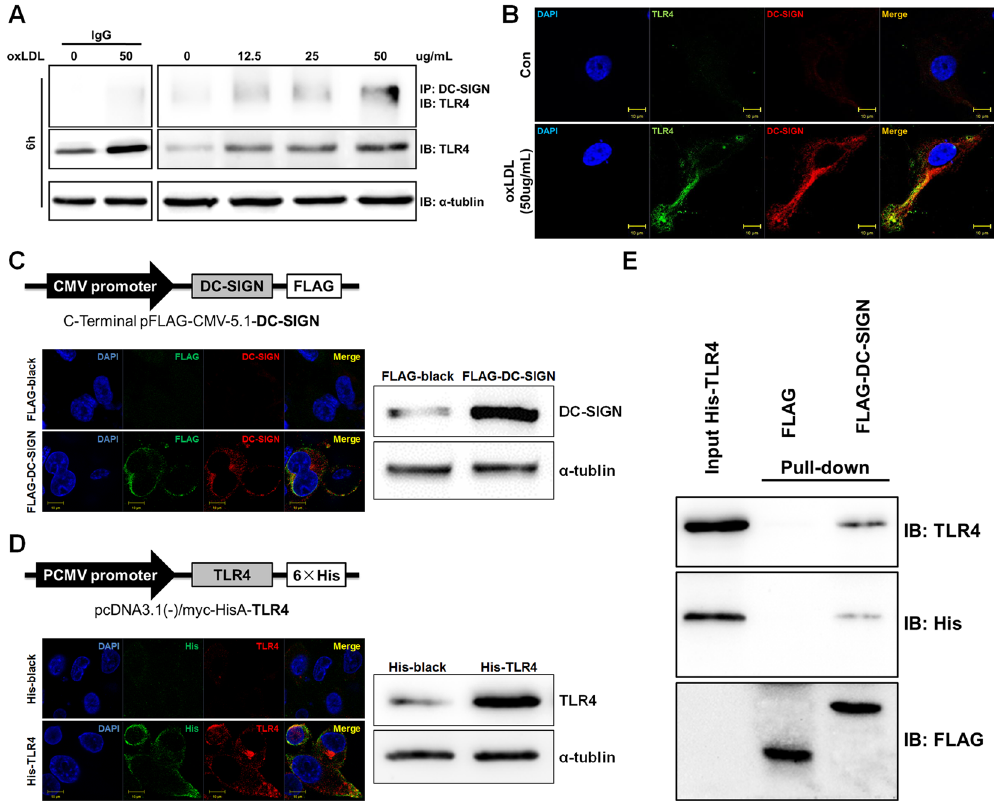
Figure 4. DC-SIGN interacted with and bound TLR4. ( A ) Macrophages were incubated with oxLDL (0, 12.5, 25 and 50 μ g/ml) for 6 hours. Cell lysates were immunoprecipitated with a DC-SIGN antibody and probed with an antibody against TLR4. As loading controls, whole cell lysates were probed with antibodies against total TLR4 and α -tubulin. The IgG control had been detected in another Western-blot assay, where the protein level and exposure time were same Western-blot results on the right. ( B ) Macrophages were stimulated with or without 50 μ g/ml oxLDL and stained with DC-SIGN (red) and TLR4 (green). Images were acquired by confocal microscopy (1,200x). Yellow indicates co-localization of the two proteins. ( C and D ) The maps of pFLAG-CMV- 5.1-DC-SIGN and pcDNA3.1 ( − )/myc-HisA-TLR4 are shown. pFLAG-CMV-5.1-DC-SIGN or pcDNA3.1 ( − )/ myc-HisA-TLR4 were transfected into HEK293 cells. The localization patterns of FLAG-DC-SIGN (FLAG: green, DC-SIGN: red) and His-TLR4 (His: green, TLR4: red) were detected by immunofluorescence stains, and the overexpression efficiency of FLAG-DC-SIGN and His-TLR4 were measured by western blot analysis. ( E ) In vitro pull-down of FLAG-DC-SIGN and His-TLR4 fusion proteins. The total cell lysate (10 μ g) of FLAG and FLAG-DC-SIGN were absorbed onto anti-FLAG M2 beads and incubated with the whole cell lysate (10 μ g) His-TLR4. Elutes were analyzed by SDS-PAGE followed by immunoblotting with anti-TLR4, anti-His and anti- FLAG. IB: Immunoblotting, IP: